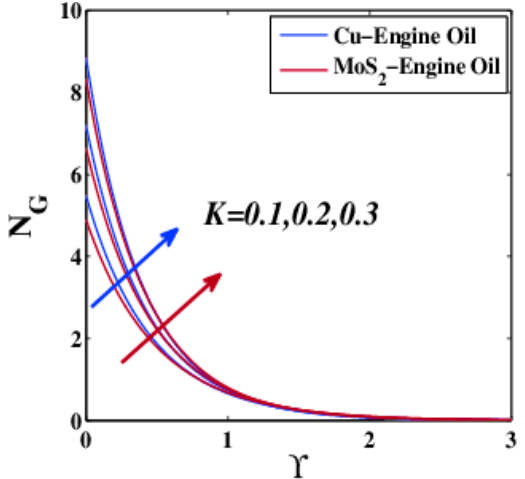
Figure 11. Temperature variation 𝜃(𝛶) under the influence of 𝐾 .